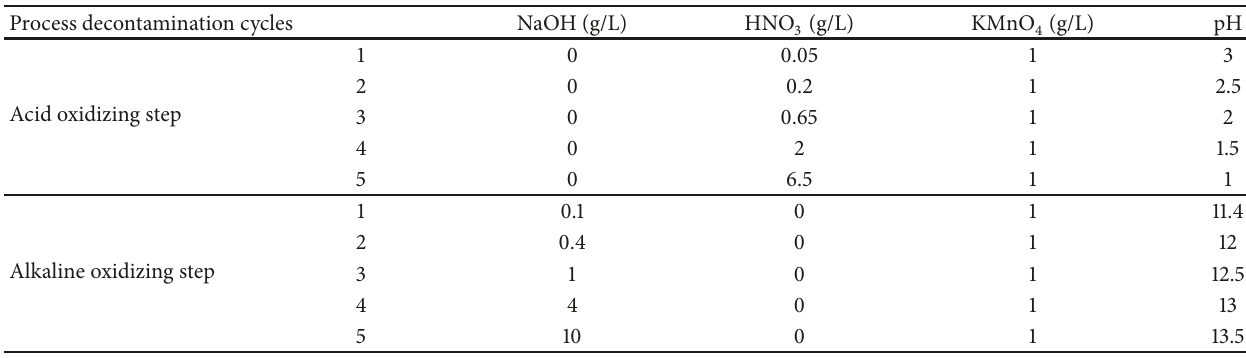
Table 2: Oxidizing decontamination